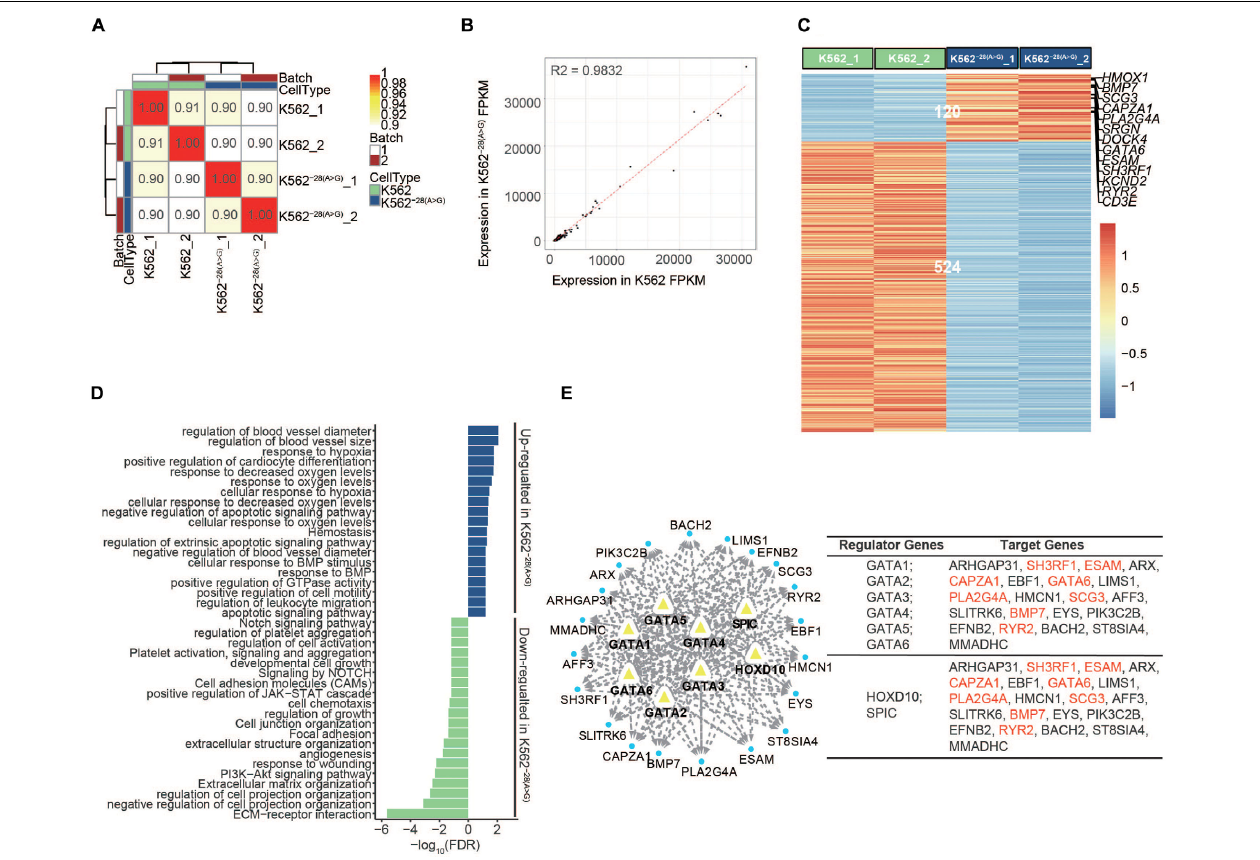
FIGURE 2 | Transcriptome analysis of K562 and K562 − 28 ( A > G ) cell lines before erythroid differentiation. (A) Pairwise Pearson correlations are represented in matrix between K562 and K562 − 28 ( A > G ) in two batches before differentiation. (B) The correlation between K562 and K562 − 28 ( A > G ) before differentiation. (C) Heat map shows the differentially expressed genes (DEGs) between K562 and K562 − 28 ( A > G ) cell lines; genes related to hypoxia are showed on the right. (D) Enrichment analysis of GO, KEGG, and Reactome pathways based on DEGs in K562 − 28 ( A > G ) before differentiation; the upregulated pathways are shown in blue, and the downregulated pathways are shown in green. (E) The predicted interaction network of transcription factors (TFs) in DEGs and their target genes in K562 − 28 ( A > G ) before differentiation. The hypoxia genes are shown in